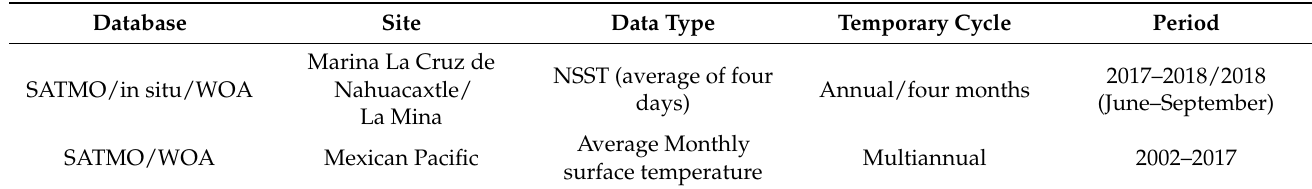
Table 2. Characteristics of the SST data for each